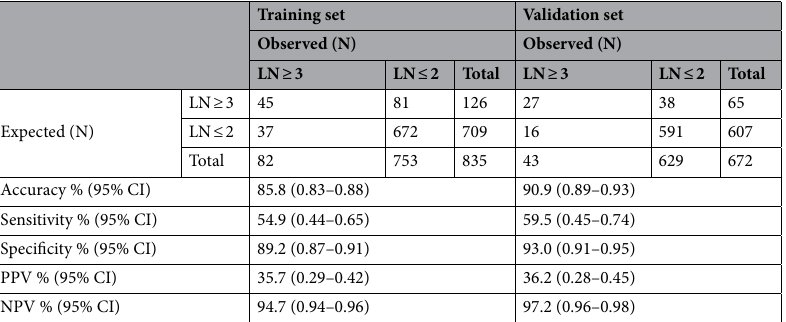
Table 5. Two-way contingency table analysis showing predictive accuracy of the nomogram. LN , Lymph node; PPV , Positive predictive value; NPV , Negative predictive value; CI , Confidence interval.